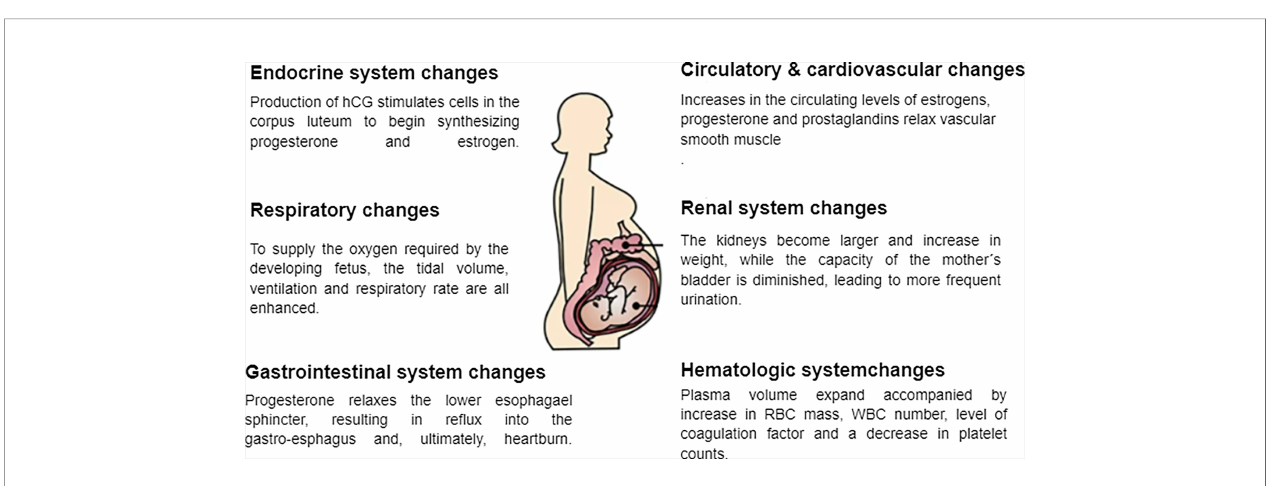
FIGURE 1 | Physiological changes associated with